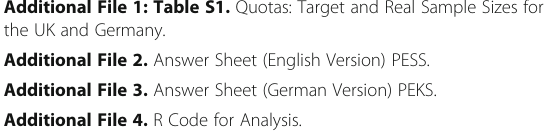
Additional File 1: Table S1. Quotas: Target and Real Sample Sizes for the UK and Germany. Additional File 2. Answer Sheet (English Version) PESS. Additional File 3. Answer Sheet (German Version) PEKS. Additional File 4. R Code for